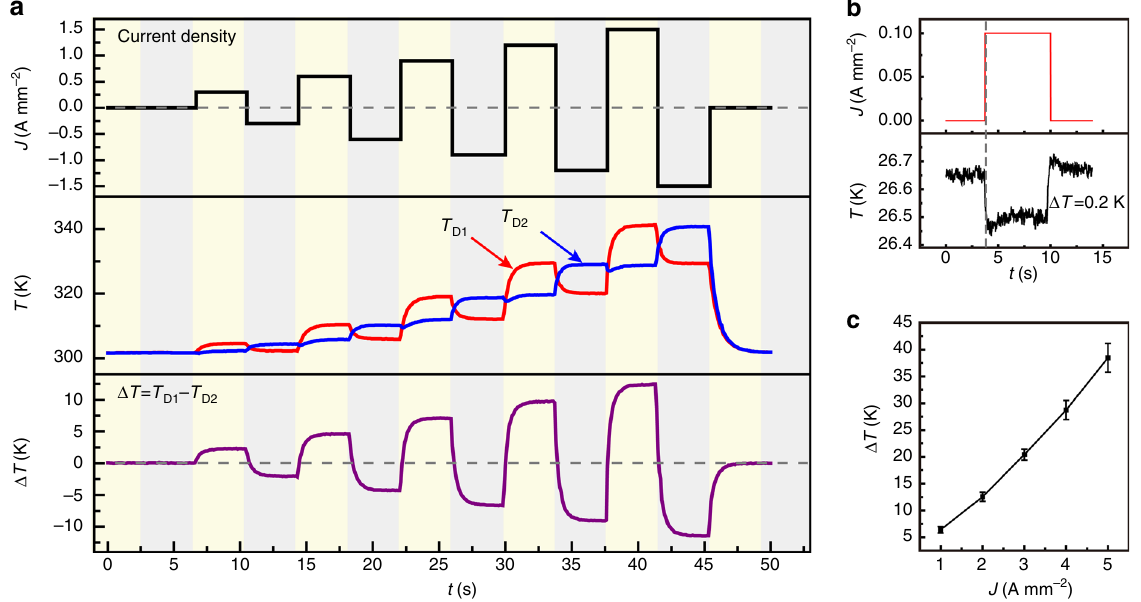
Fig. 4 Real-time characterization of the temperature differences. a Real-time temperature of the two contacts in an organic thermoelectric (OTE) device and the extracted temperature differences at different current densities. The thermal equilibrium is established within 3 s. b Peltier-effect-induced temperature at the cooling contact of an OTE device under a current density of 0.1 A mm − 2 . c Current-density-dependent temperature differences at the two contacts of the device. A large temperature difference of up to 41 K is observed at the current density of 5 A mm −